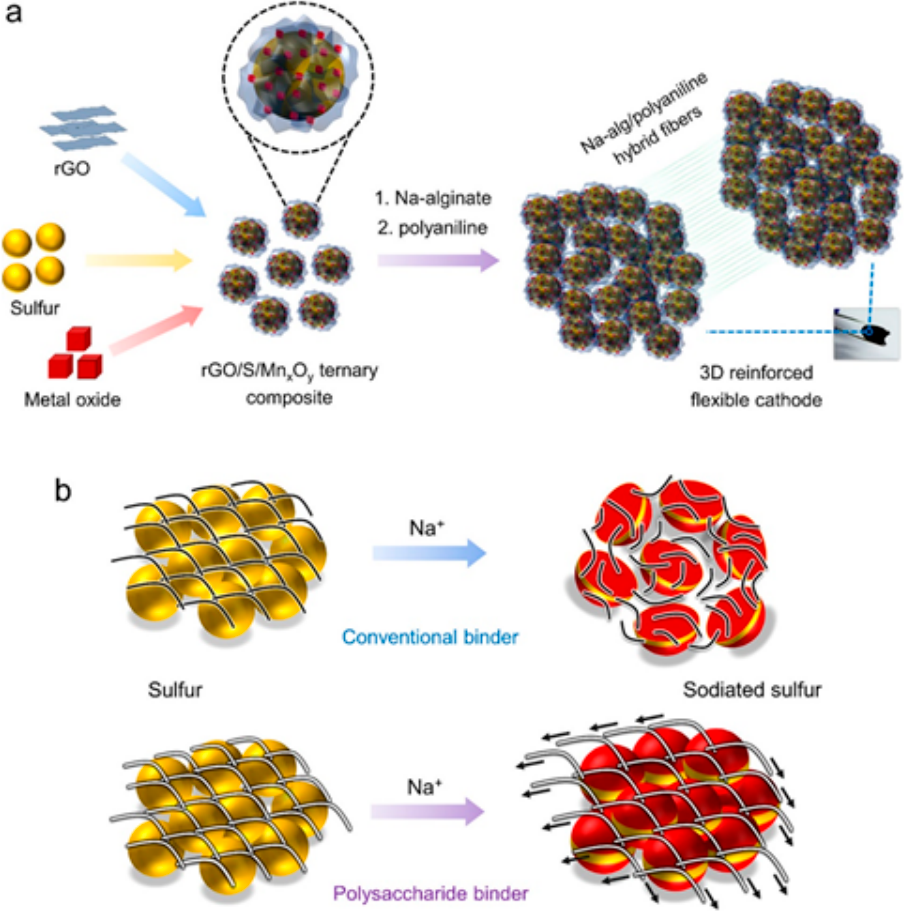
Figure 3. Schematic illustration of freestanding cathode synthesis and the role of the binder. ( a ) Schematic illustration of the free-standing cathode preparation. ( b ) Schematic of the proposed role of the polysaccharide binder to counteract volume expansion of sulfur during sodium-ion insertion [22]. Reprinted with permission from Ghosh, A.; Kumar, A.; Roy, A.; Panda, M.R.; Kar, M.; MacFarlane, D.R.; Mitra, S. Three-Dimensionally Reinforced Freestanding Cathode for High-Energy Room- Temperature Sodium–Sulfur Batteries. Copyright 2019, American Chemical Society.